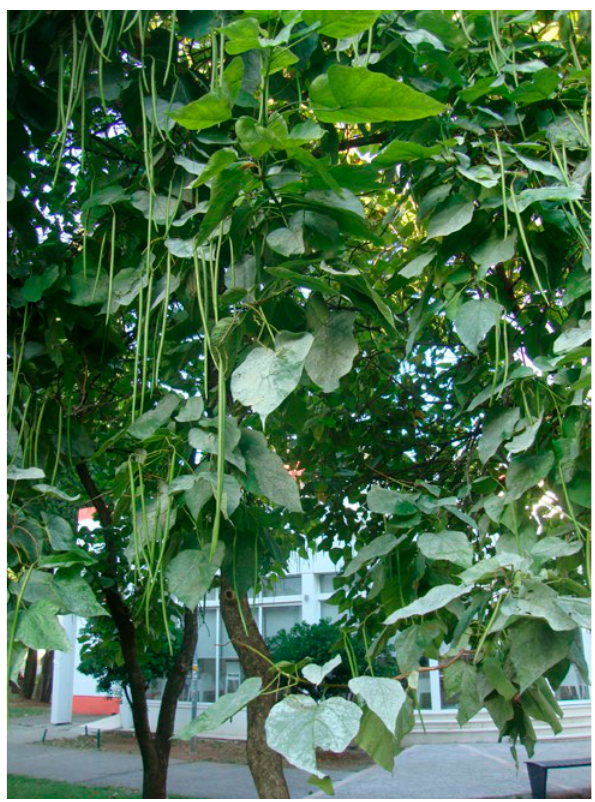
Figure 1. Symptoms of powdery mildew on severely-affected catal- pa